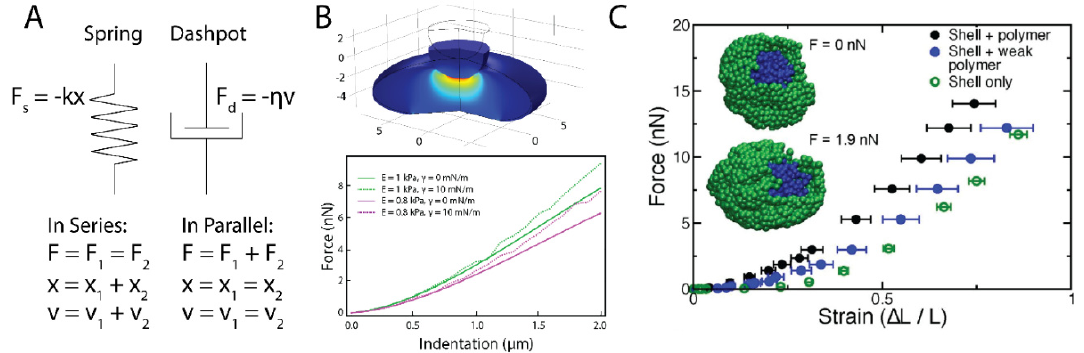
Figure 1. ( A ) Common components for 1D viscoelastic schematic models where F is the force across a given element, k is the spring constant, η is the viscosity, x is displacement, and v is velocity. ( B ) A continuum mechanics (CM) model of atomic force microscopy where the nucleus is treated as an elastic solid surrounded by a thin, elastic shell. The axes represent distance in µ m. Force versus indentation data show strain sti ff ening during compression where the small indentation regime is dictated by the elastic solid and the large indentation regime is dominated by stretching of the elastic shell. Reprinted with permission from Hobson et al. (2020) [7]. ( C ) A molecular dynamics (MD) simulation of micromanipulation of an isolated nucleus. The nucleus is modeled to have a crosslinked polymeric interior that is linked to a polymeric shell. The presence of the polymer interior dictates the initial force response while the shell results in a strain-sti ff ening response during long extension. Reprinted with permission from Stephens et al. (2017)